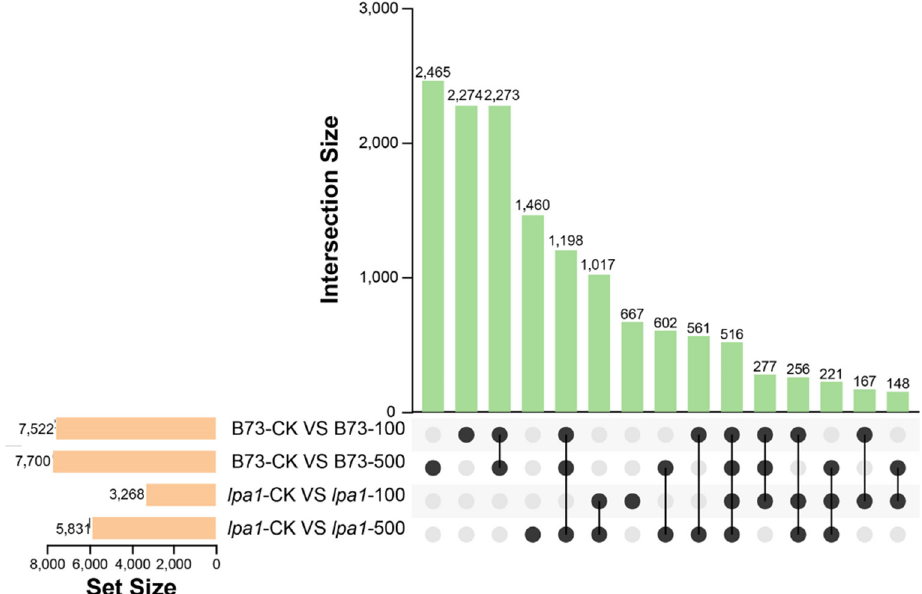
Figure 5. Upset plot analysis of DEGs in B73 and lpa1 under different treatments. The columns indicate DEGs under single or multiple processes, the x -axis represents combinations of different groups (black dots represent single-treatment comparisons, black lines connected by dots represent multiple-treatment comparisons) and the y -axis represents the number of genes corresponding to the combinations.